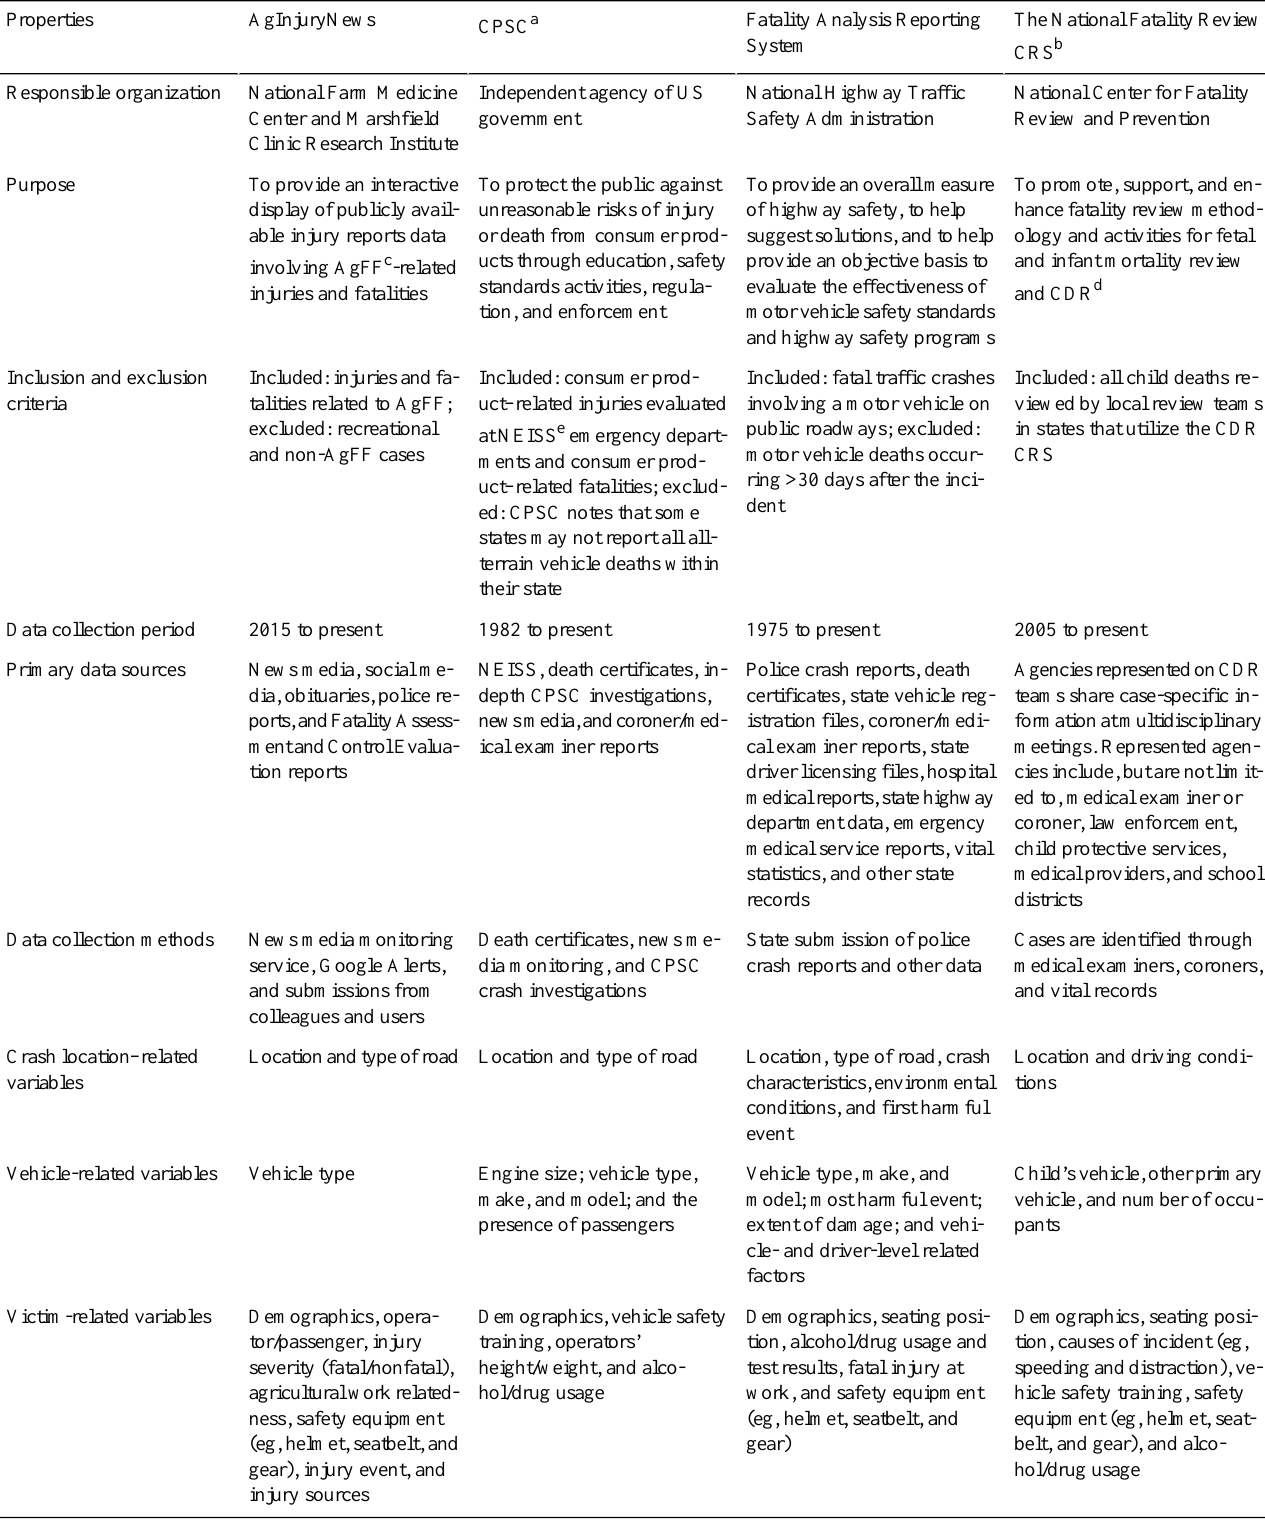
Table 2. Characteristics of national data sources for all-terrain vehicle–related